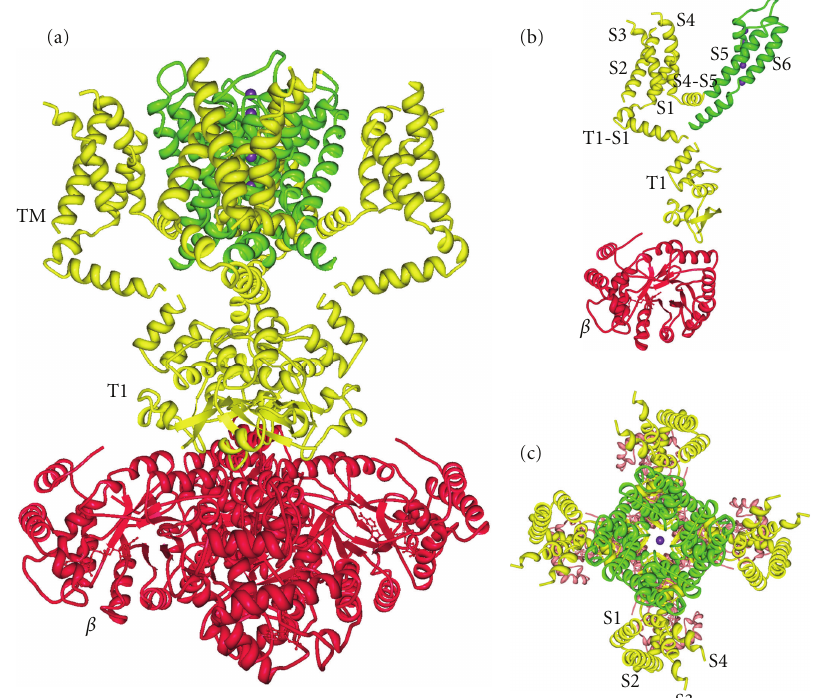
Figure 1: Views of the K v 1.2- β 2 subunit complex. (a) Side view of the K v 1.2- β 2 structure with the extracellular solution above and the intracellular solution below. Four subunits of the channel are colored in yellow (T1 domain and voltage sensor) and green (pore). β subunit tetramer is colored in red. TM indicates the integral membrane component of the complex. (b) Stereoview of a single subunit of the channel and β subunit viewed from the side. Labels correspond to six transmembrane helices (S1 to S6). (c) View of the K v 1.2- β 2 structure from the extracellular side of the membrane. S1–S4 helices from each subunit form four surrounding voltage-sensing domains, S5-S6 regions (green) from the four subunits shape a single pore domain. Purple spheres are potassium ions. Images were generated using Protein Workshop Viewer 3.9 [15] and Protein Data Bank accession ID 2A79